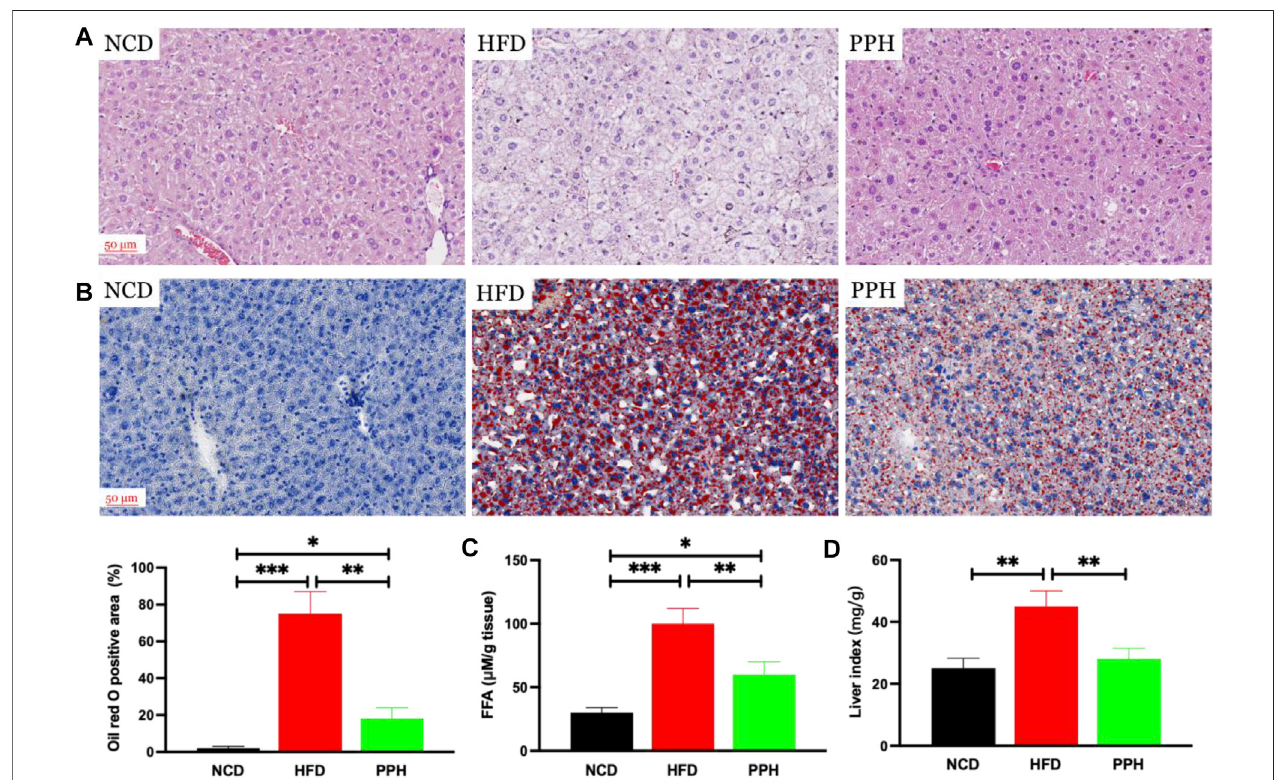
FIGURE 2 | PPH decreased lipid accumulation in liver. Hematoxylin and eosin (H,E) staining (A) ; Oil red O staining (B) ; FFA (C) ; liver index (D) , calculated by liver weight (mg)/body weight. * p < 0.05, ** p < 0.01, and *** p < 0.001.